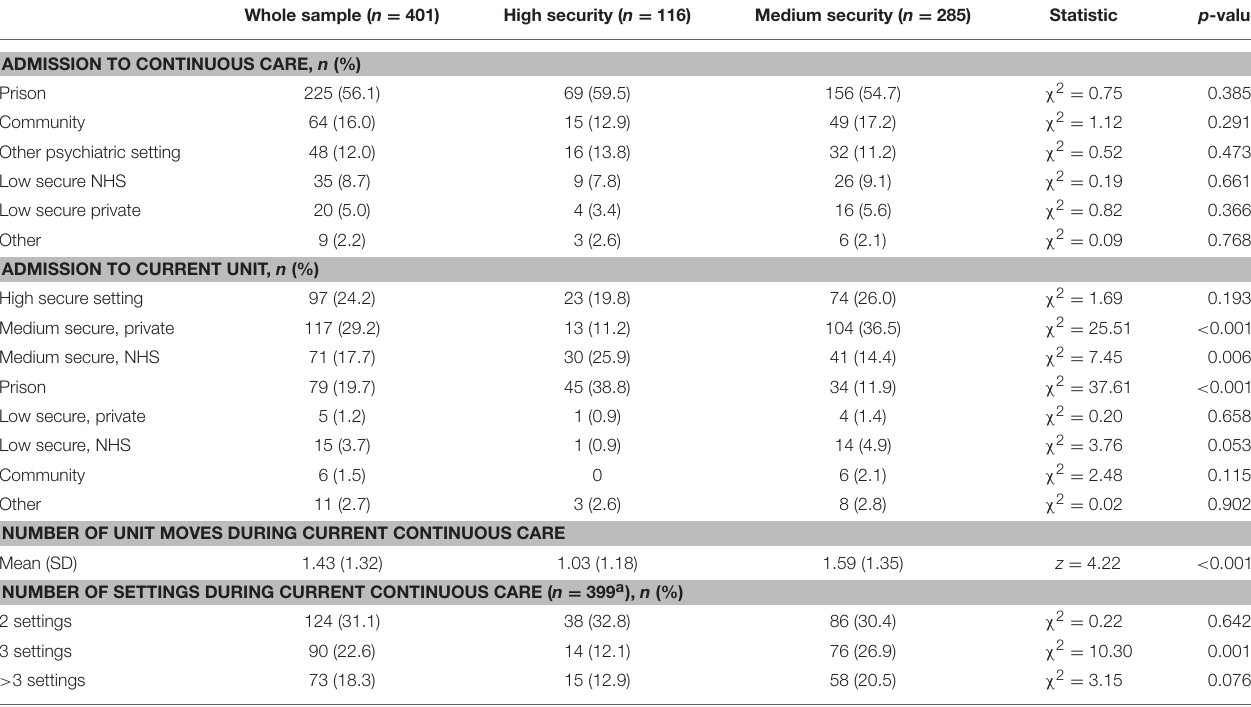
TABLE 3 | Admission source and moves between settings for long-stay forensic